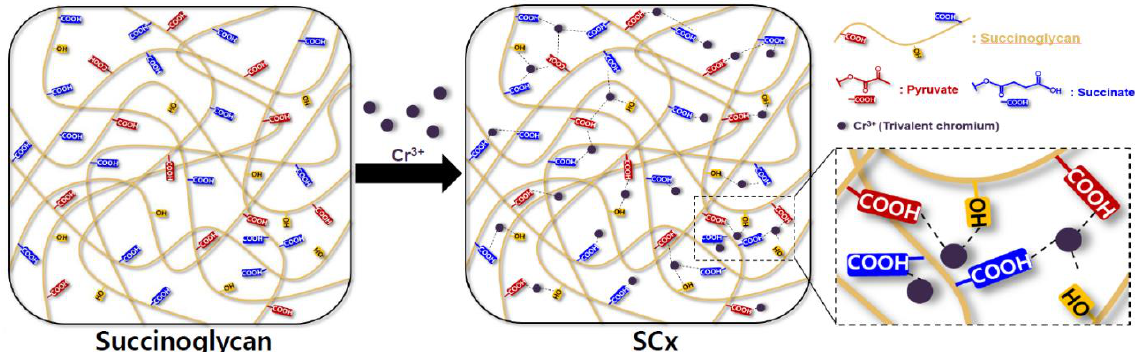
Figure 3. Fourier transform infrared (FTIR) spectra: ( a ) succinoglycan, ( b ) SC 13.2 , ( c ) SC 26.4 , and ( d ) SC 52.8 .